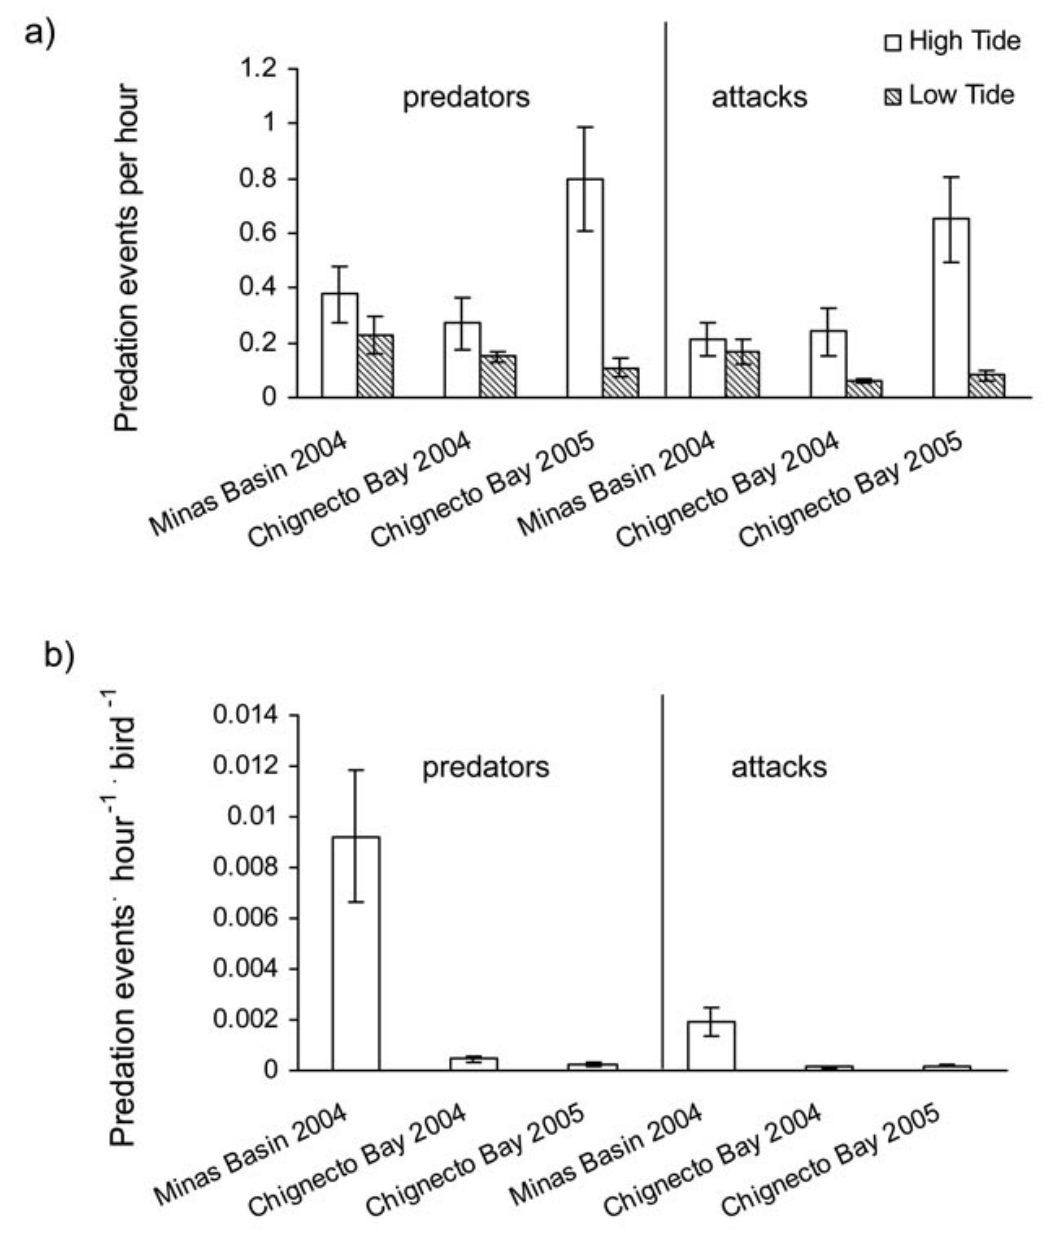
Fig. 5. (a) Mean number of predators and attacks per hour for each 4-h observation period at low tide (on foraging sites) and 2-h observation period at high tide (on roosting sites) on sites in the upper Bay of Fundy. (b) Mean number of predators and attacks per hour at low tide on a per sandpiper basis in the same areas. Error bars are ± 1 SE. Statistical comparisons reported in the text do not include Minas Basin